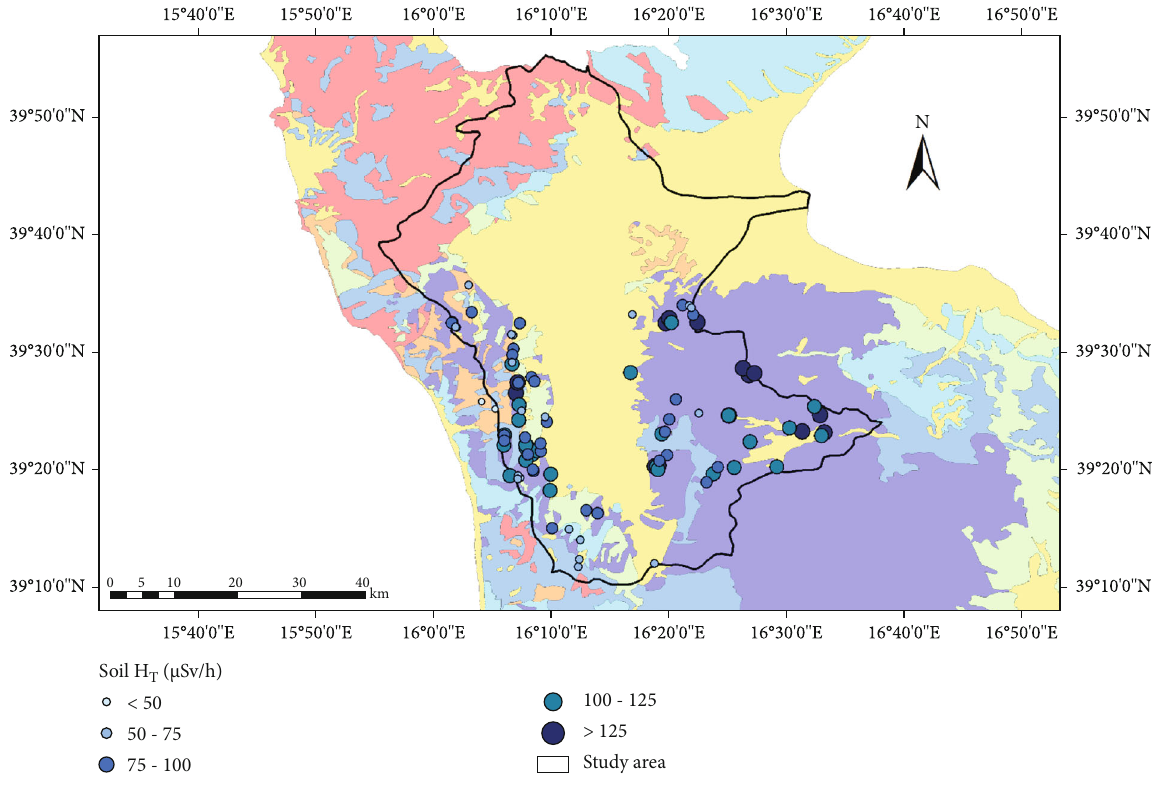
Figure 4: Dot map of equivalent dose rate in soils.